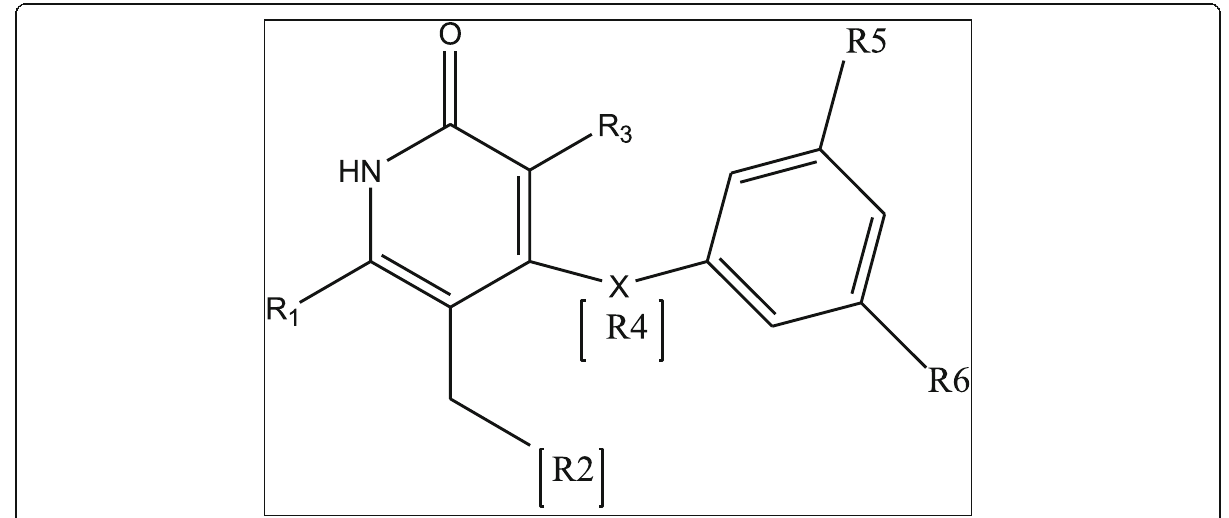
Fig. 2 Molecular template of 4-arylthio and 4-aryloxy-3-iodopyridine-2(1H)-one derivatives utilized for fragmentation pattern (R 1 – R 6 are substitution